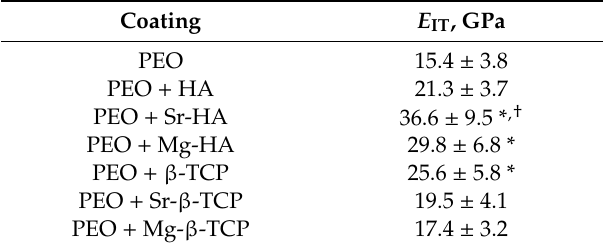
Table 4. Young’s modulus of CaP PEO and composite